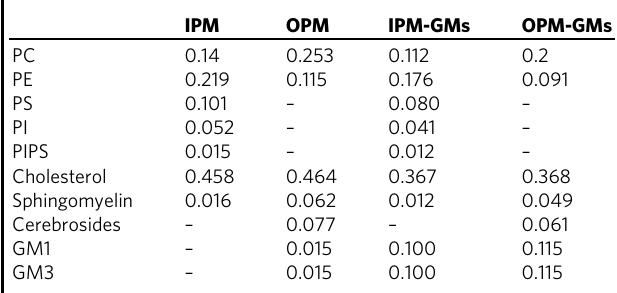
Table 1 Molar fractions of the lipid bilayers used in this